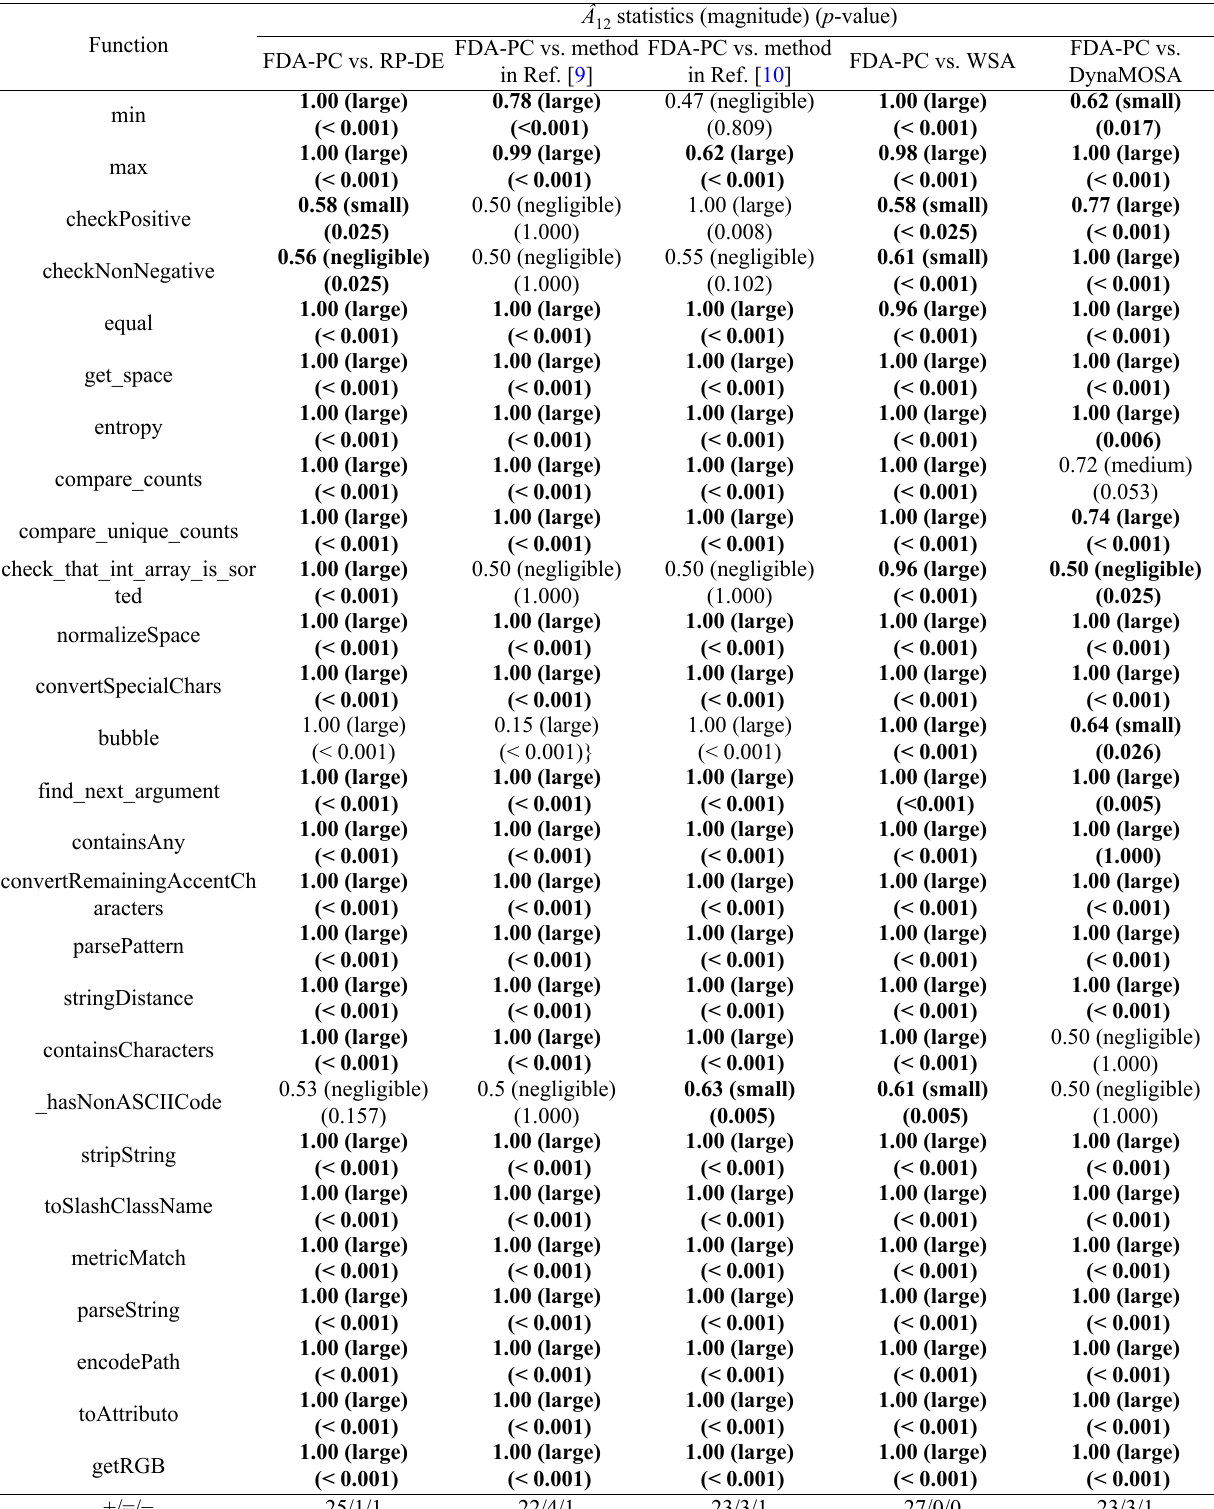
Table 4 Effect size and statistical significance achieved for each program following a comparison of FDA-PC with alternative